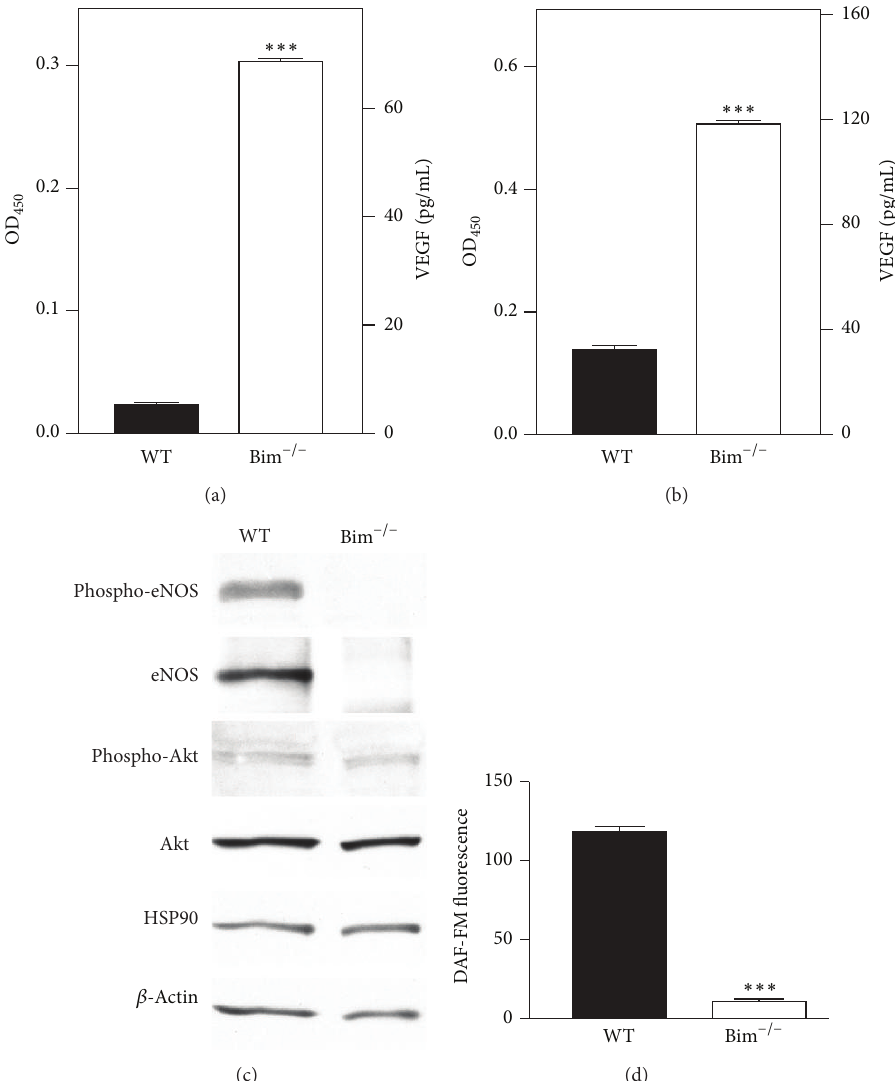
Figure 7: Decreased eNOS and increased VEGF expressions in Bim −/− vascular cells. In panels (a) and (b), an immunoassay was used to determine VEGF levels (pg/mL) in retinal endothelial cells (a) and pericytes (b) from wild-type and Bim −/− mice. Protein lysates (20 𝜇 g) from wild-type and Bim −/− retinal endothelial cells were analyzed by Western blot analysis for the expression of phospho-eNOS, eNOS, HSP90, phospho-Akt, and Akt (panel (c)). 𝛽 -Actin expression was assessed as a loading control (panel (c)). In panel (d), the intracellular NO production was determined as analyzed by DAF-FM fluorescence for retinal endothelial cells. Please note that the increased VEGF expression was independent of eNOS expression in Bim −/− endothelial cells ( ∗∗∗ 𝑃 < 0.001